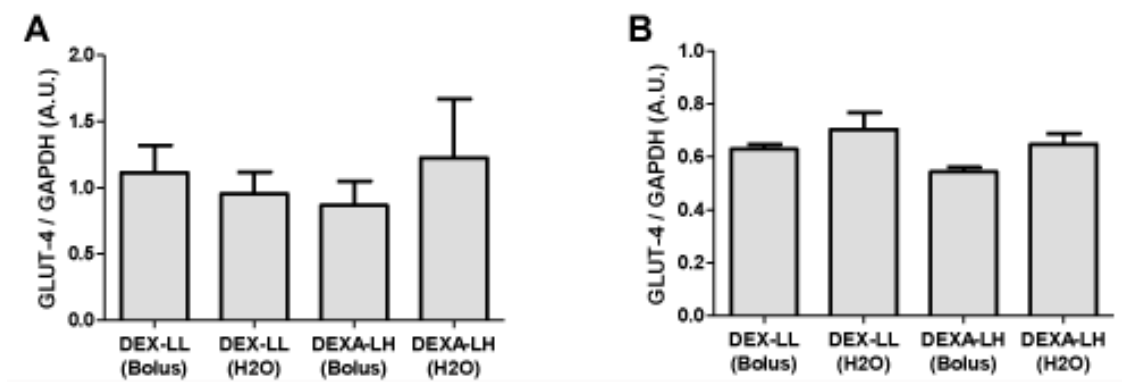
Figure 5. GLUT-4 gene expression in ( A ) soleus and ( B ) EDL muscles. Values are expressed as mean ±